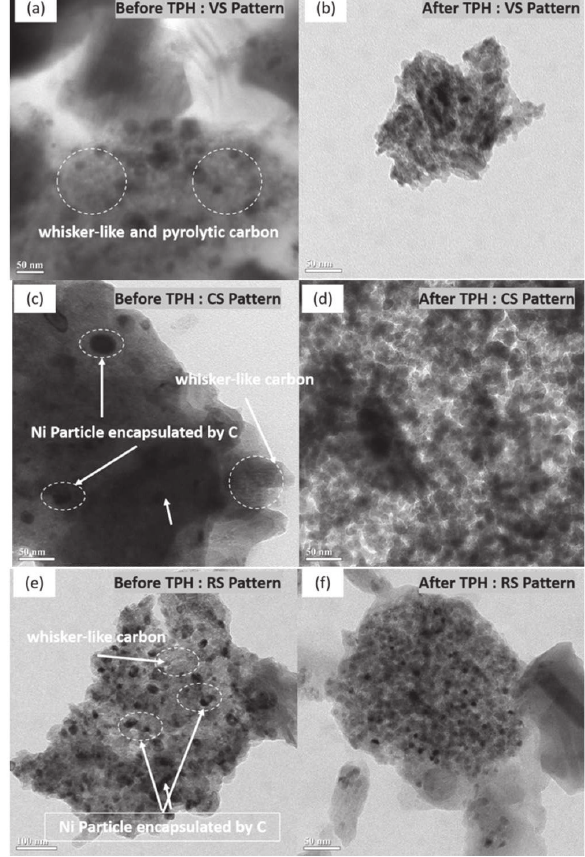
Fig. 9 – TEM images of (a) and (b) VS; (c) and (b) CS; (e) and (f)